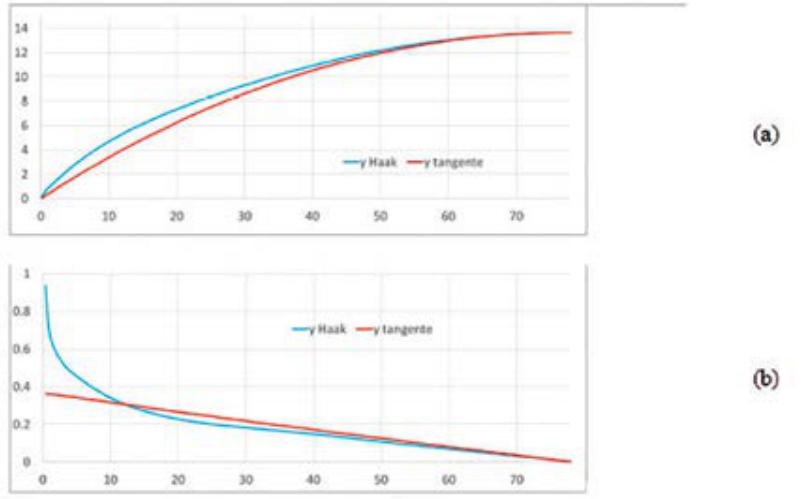
Figure 11. Comparison between models with tangent–ogive and Haak fore bodies: (a) geometries; (b) first